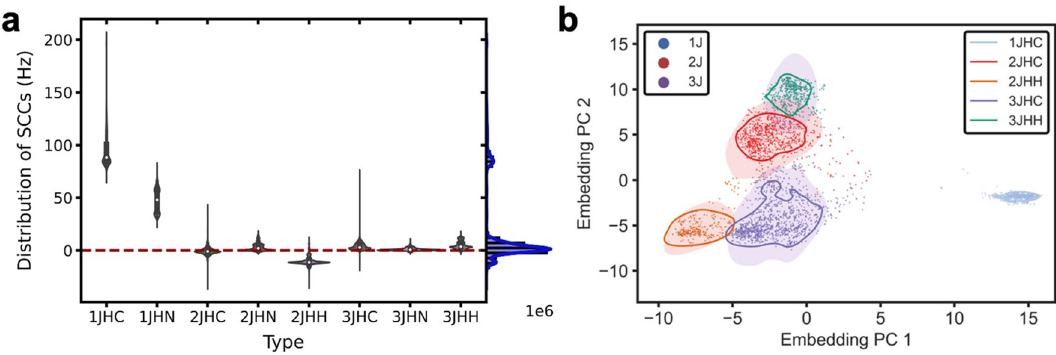
Figure 4. The embedding of GAANN. ( a ) Distribution of 8 types of coupling constants in the violin plot. The kernel density distribution of SCCs is shown on the right. Most of values gather around 0 Hz. The coupling type value of 1 J is significantly higher than that of 2 J and 3 J. The coupling constant values of 2 J and 3 J are concentrated near 0 value, and the difference of them is subtle. ( b ) Embedding learning of GAANN. SCCs are represented as individual points in the two-dimension plane. Shaded areas are the distribution of kernel density estimates of 1 J, 2 J and 3 J coupling, and there is not much overlap between 2 and 3 J coupling. Enclosed contoured lines are the distribution of kernel density estimates of 1 J CH , 2 J CH , 2 J HH , 3 J CH , 3 J HH . The regions surrounded by the five coupling kernel density contours, separate each other